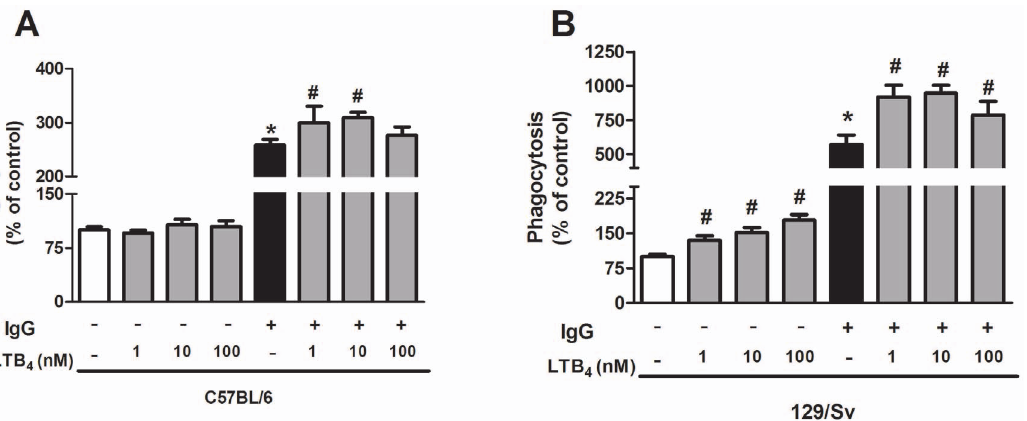
Figure 6. Effect of exogenous LTB 4 on the phagocytosis of yeast by C57BL/6 and 129/Sv macrophages. PMs from C57BL/6 (A) and 129/ Sv (B) mice were incubated for 2 h with IgG-opsonized or non-opsonized yeast at a yeast-to-cell ratio of 1:5 in the presence or absence of exogenous LTB 4 . The data are expressed as the mean 6 SEM from one representative experiment of a total of two experiments (n=3 to 5). *sv129 compared with C57BL/6; # 129/Sv and C57BL/6 compared to LTB 4 treatment. p , 0.05 was considered significant.